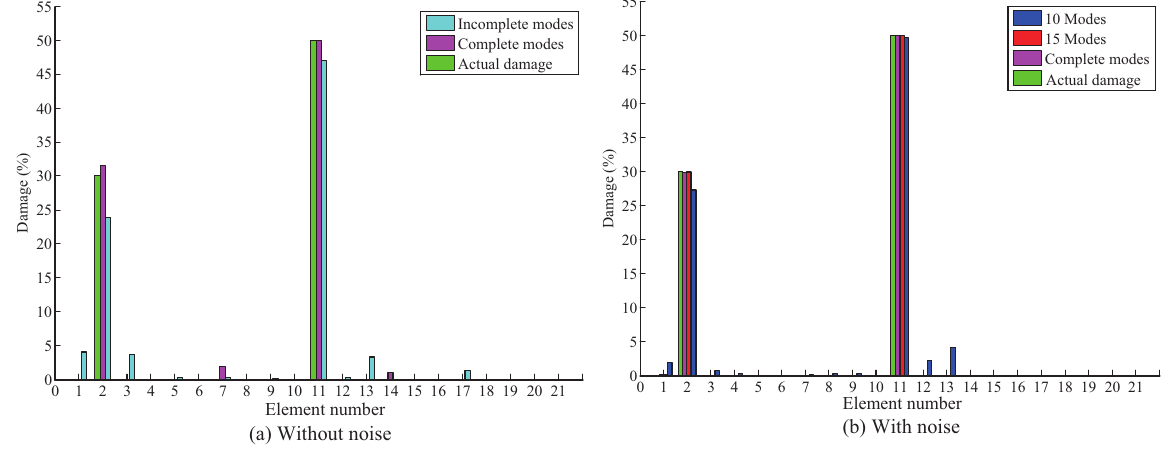
Fig. 8. Damage distribution of Belgian truss using the complete and incomplete modal data in Scenario